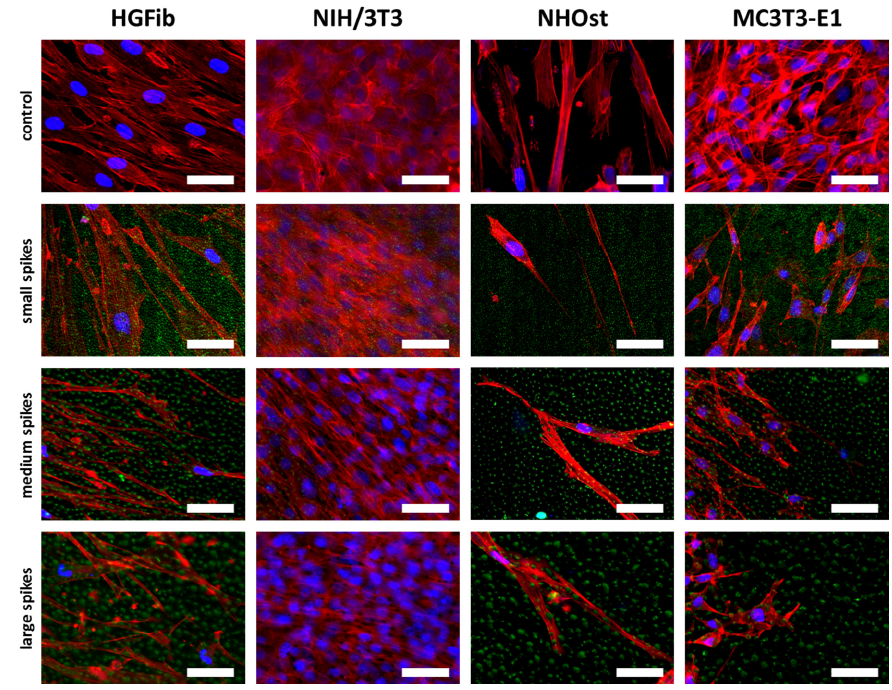
Figure 7. Cell morphologies of HGFib, NIH/3T3, NHOst, and MC3T3-E1 after migration on spike topographies. Cells on the spike structures (green) were fixed after 14 days and stained with DAPI (blue = nuclei) and phalloidin-TRITC (red = actin filaments). Scale = 50 µm.